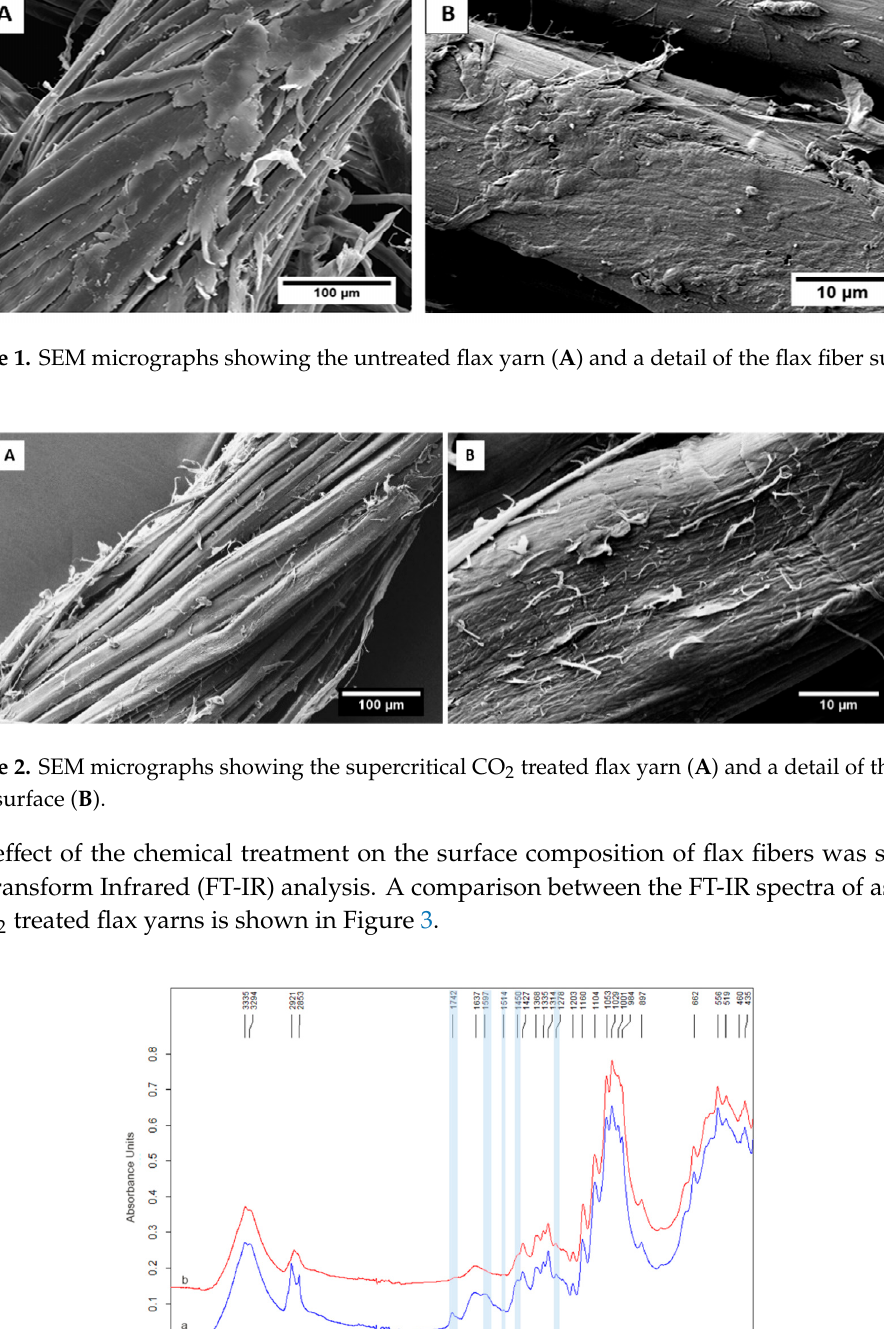
Figure 3. FT ‐ IR spectra of as ‐ received (a) and supercritical CO 2 treated flax yarns (b). The modifications resulting from the treatment are highlighted in light blue.